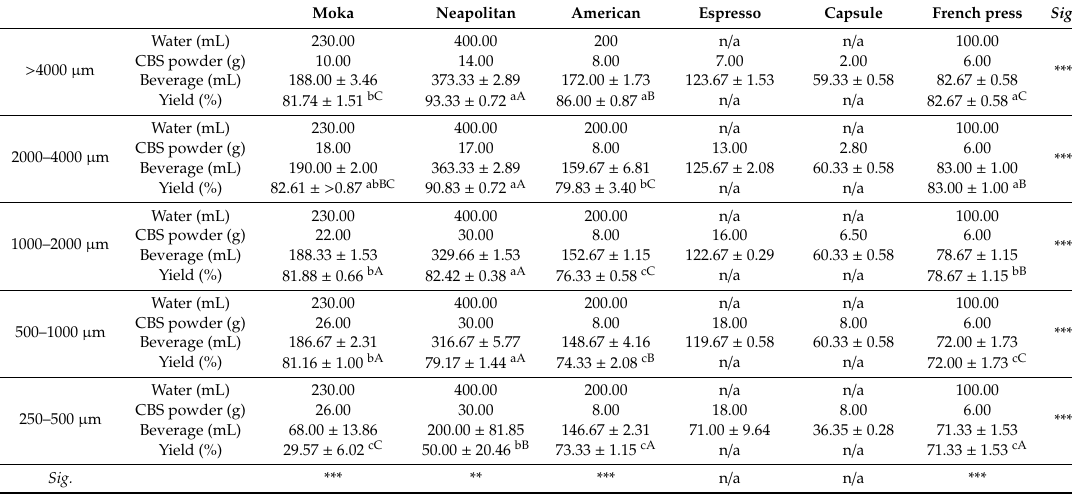
Table 1. Amounts of cocoa bean shell (CBS) powder and water utilized for the beverage preparations, volume of the obtained beverages, and process yield registered for each production technique and GD. Analysis of variance (ANOVA) was performed on the process yields among GDs and extraction